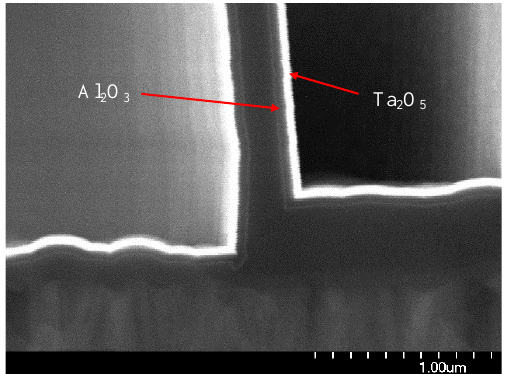
Figure 15. Cross-section SEM image of the ALD passivation lay- ers.